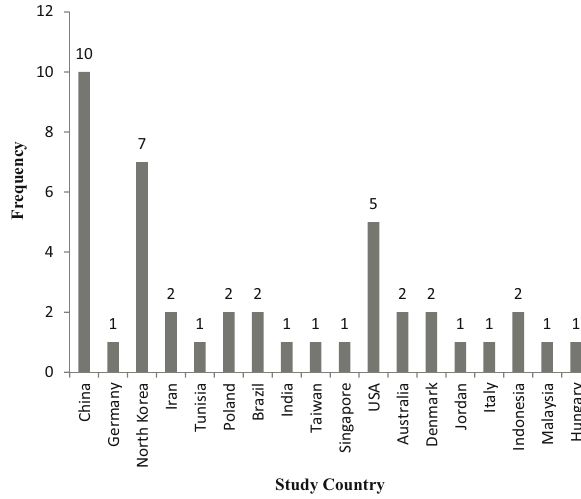
Figure 2: Plots of number of studies from each